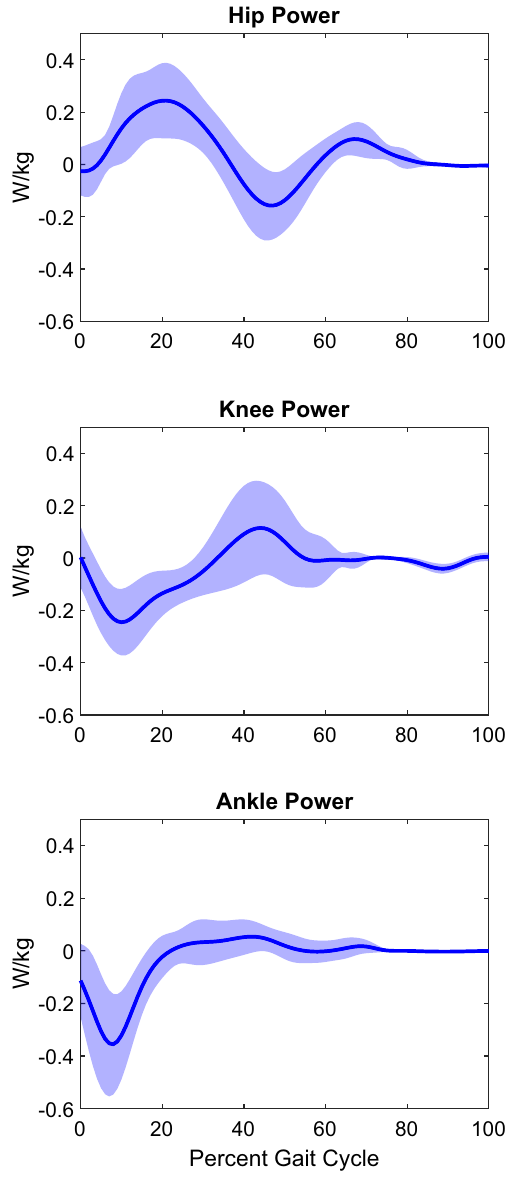
Figure 5. Joint power curves for healthy female Lewis rats. Curves are shown as mean + /− 1STDfor all three joints (hip, knee, ankle) for 24 healthy female Lewis rats. All power plots represent the sagittal plane (i.e. flexion/ extension) in